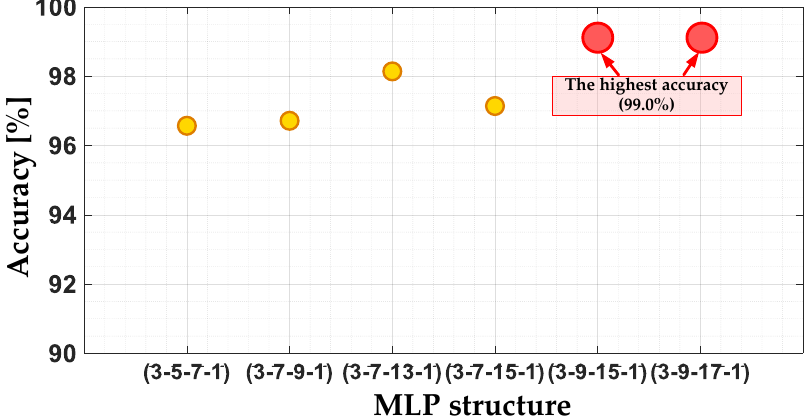
Figure 20. The impact of the MLP structure on the MLP classifier accuracy.